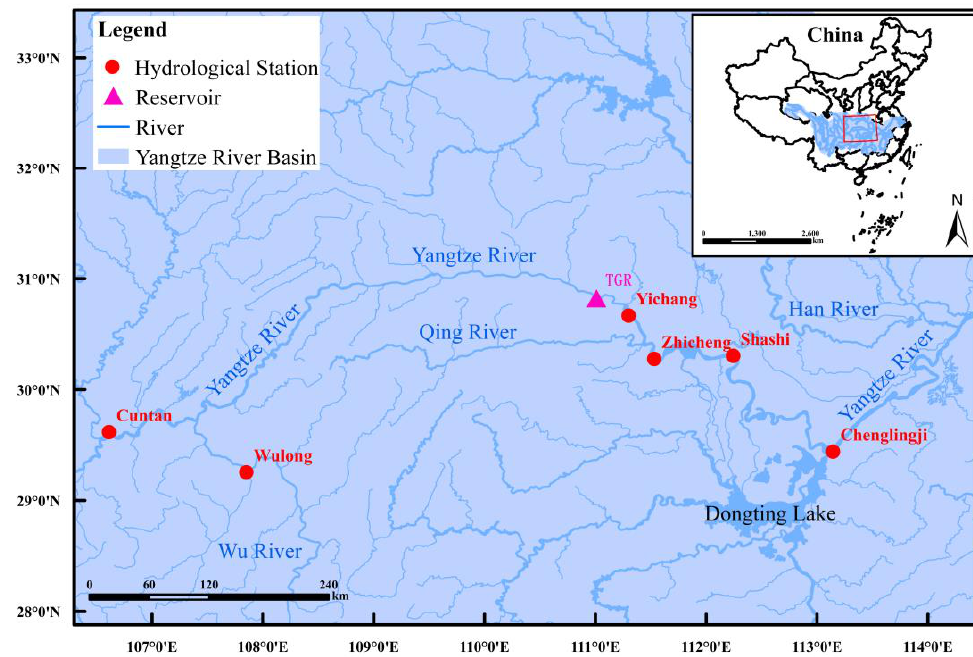
Figure 2. Schematic diagram of the Yangtze River and hydrological stations.